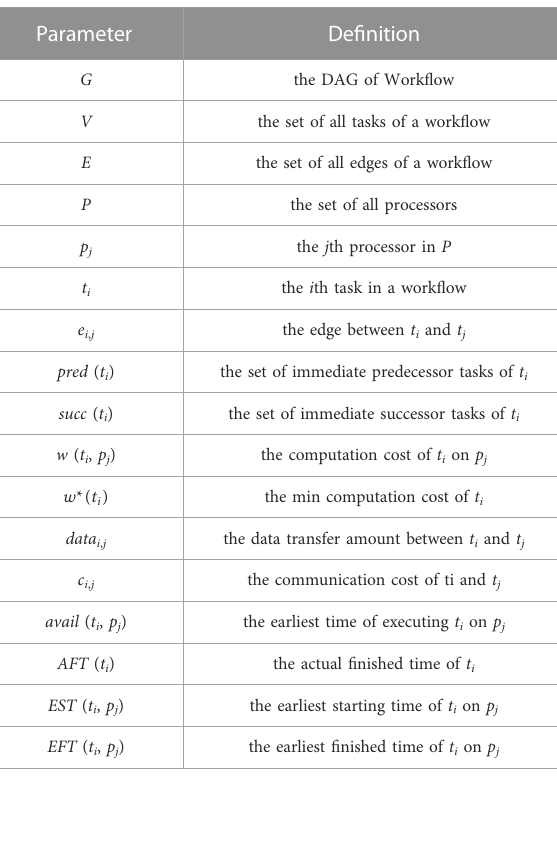
TABLE 1 Summary of